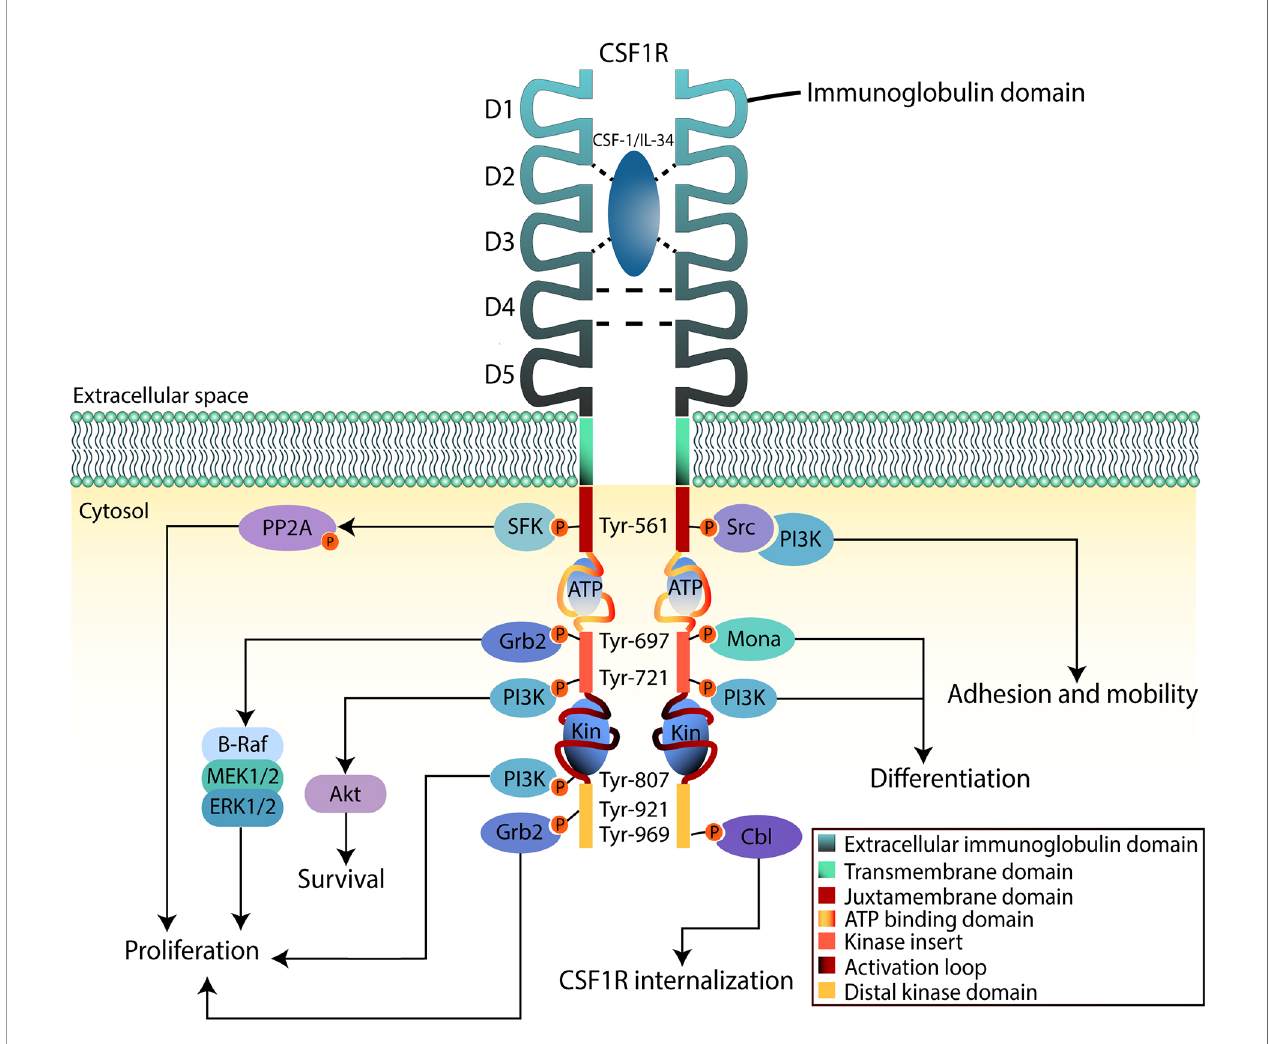
FIGURE 2 | CSF1R downstream signaling in myeloid cells. The binding region of CSF-1 or IL-34 to CSF1R is contained in the second and third domain (D2 and D3) of the extracellular region, D4 mediates homotypic interactions. Upon binding to the ligand, CSF1R dimerizes inducing tyrosine phosphorylation that will lead to activation of downstream signaling pathways. This will promote proliferation, survival, and differentiation of the cell. The intracellular region, apart from the tyrosine residues, contains an ATP-binding domain as well as catalytic domains where substrates bind (Kin). When activation takes place, these domains will fold to phosphorylate signaling